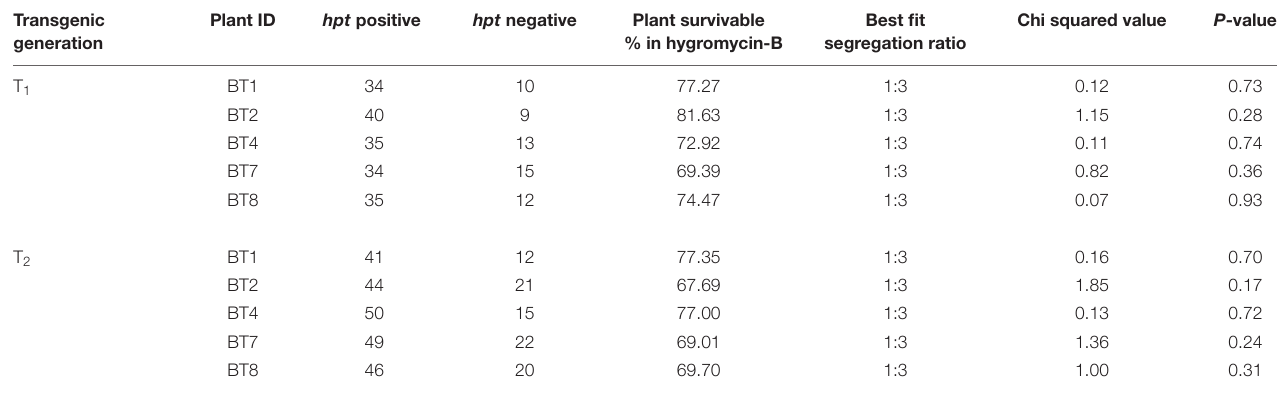
TABLE 2 | Segregation analysis of hpt gene in T1 and T2 generation progeny plants. Transgenic